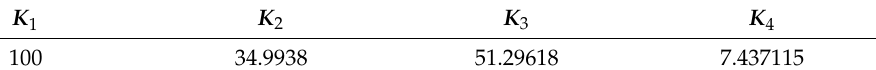
Table 4. LQR controller gains at 70% dip.